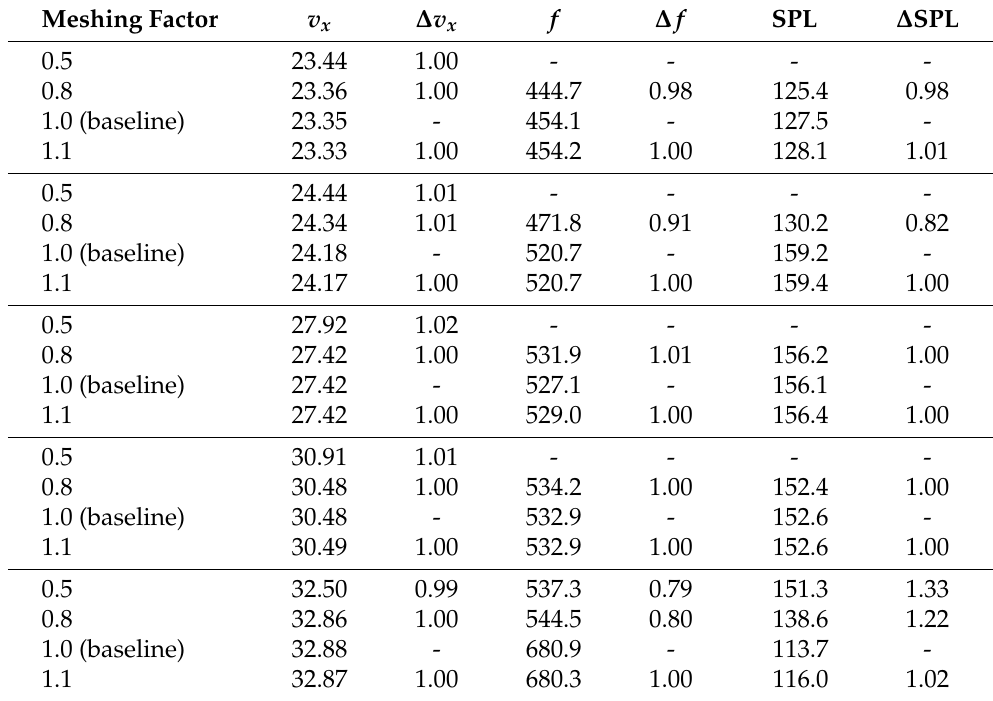
Table 1. Influence of spatial resolution on velocity, shedding frequency, and sound pressure